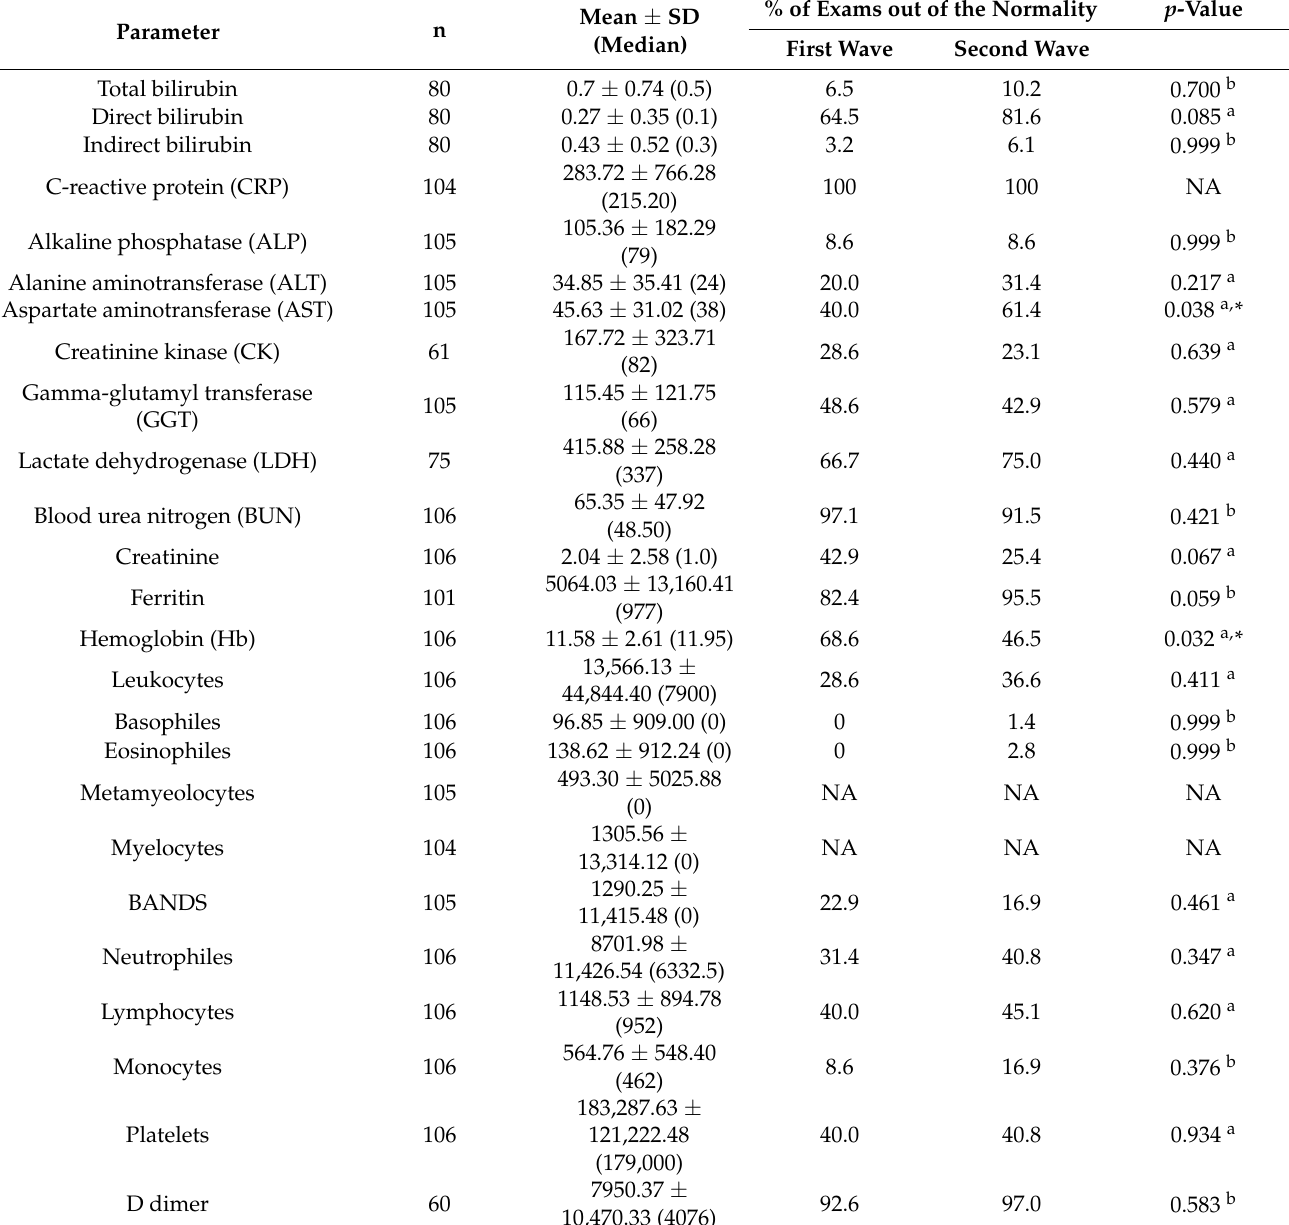
Table 8. Laboratory parameters of COVID-19 patients according to the pandemic